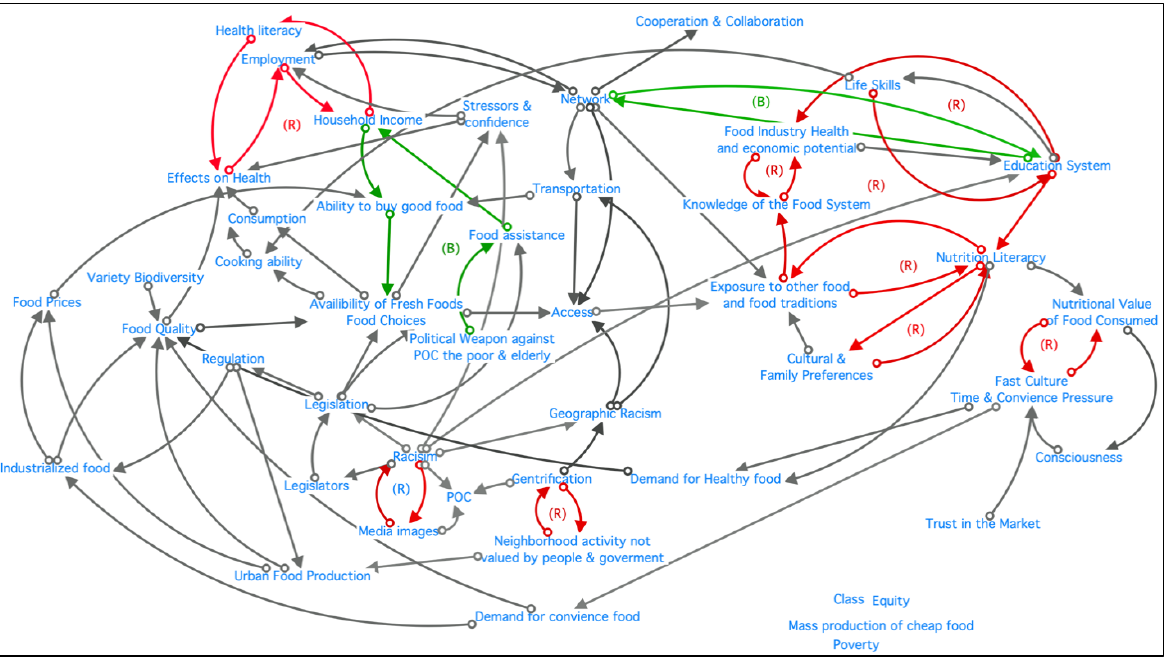
Figure 2. Aggerate Causal Loop